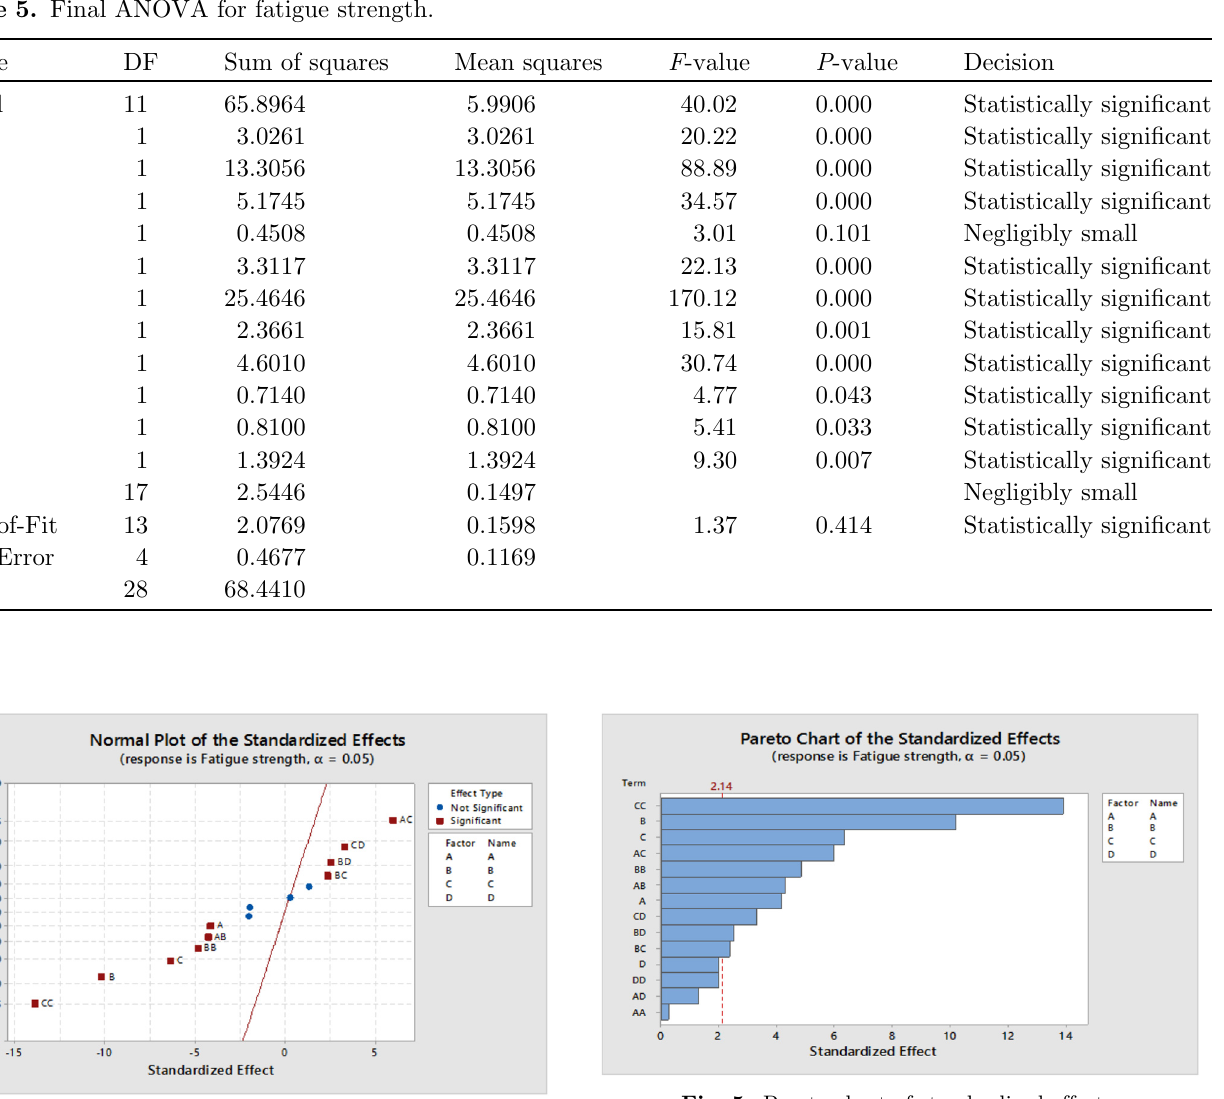
Fig. 5. Pareto chart of standardized effects.